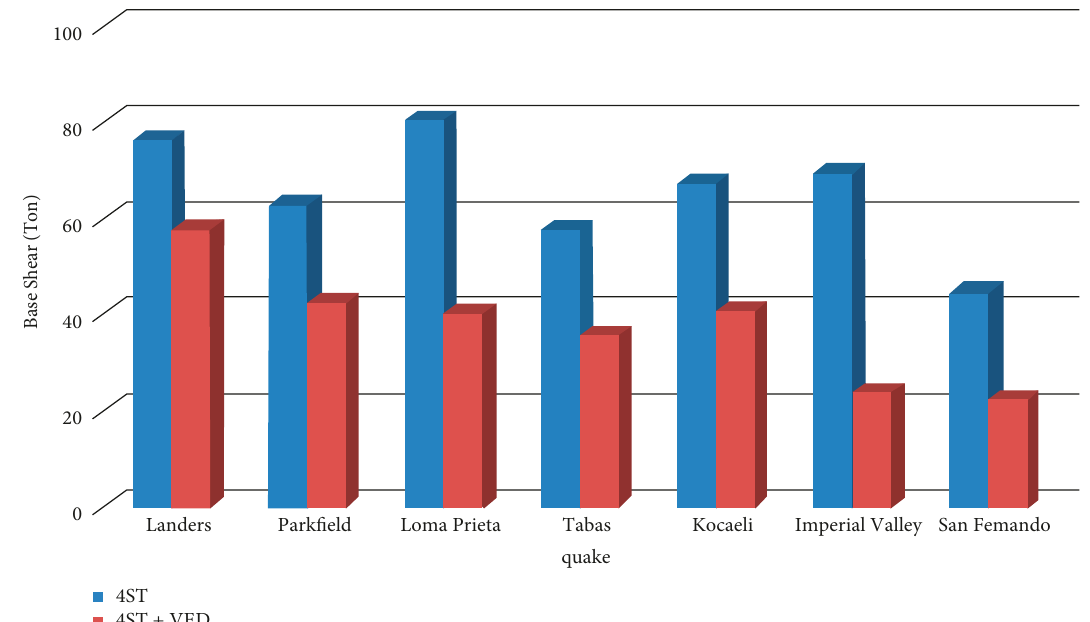
Figure 15: Shear base of a 4-story frame under near-field records in two modes with and without dampers